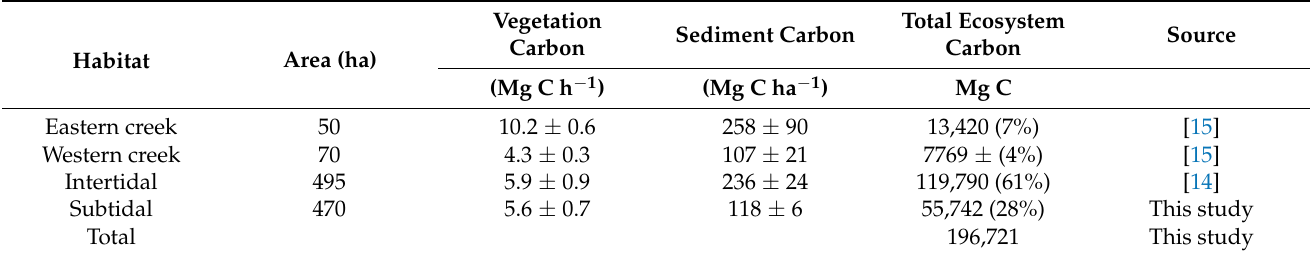
Table 7. Estimates of total ecosystem carbon stocks of seagrass meadows in Gazi